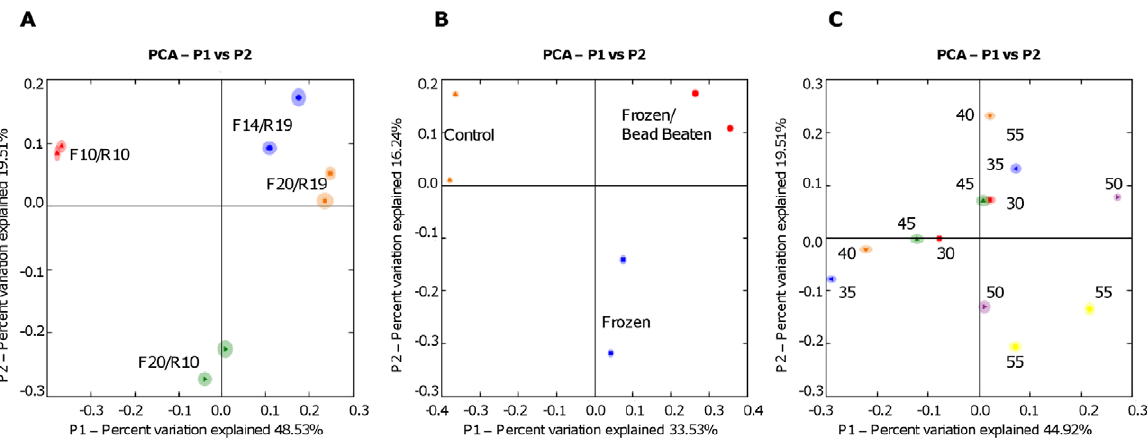
Figure 2. Hierarchical clustering visualizing the similarity of the bacterial communities as judged by pyrosequencing using different experimental procedures. All bootstrap values greater than 90% are displayed on branch lines. (a) Different primer pairs (b) Different annealing temperatures (c) Different extraction procedures. doi:10.1371/journal.pone.0038094.g002 PLoS ONE |